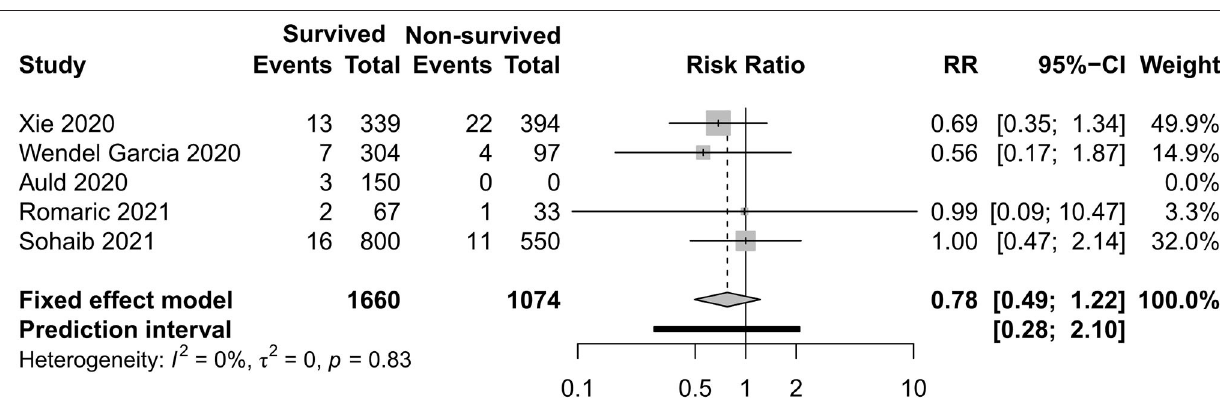
FIGURE 11 | Risk ratio of extracorporeal membrane oxygenation between survived and non-survived